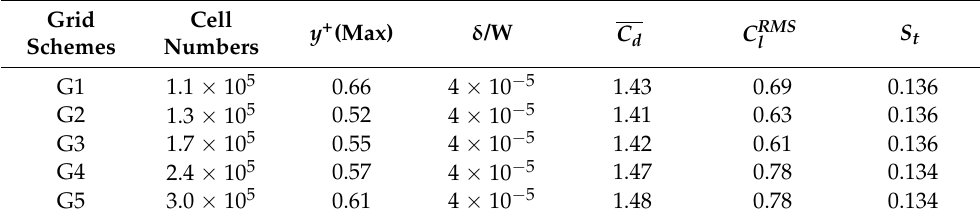
Table 1. Grid schemes for grid independence tests.